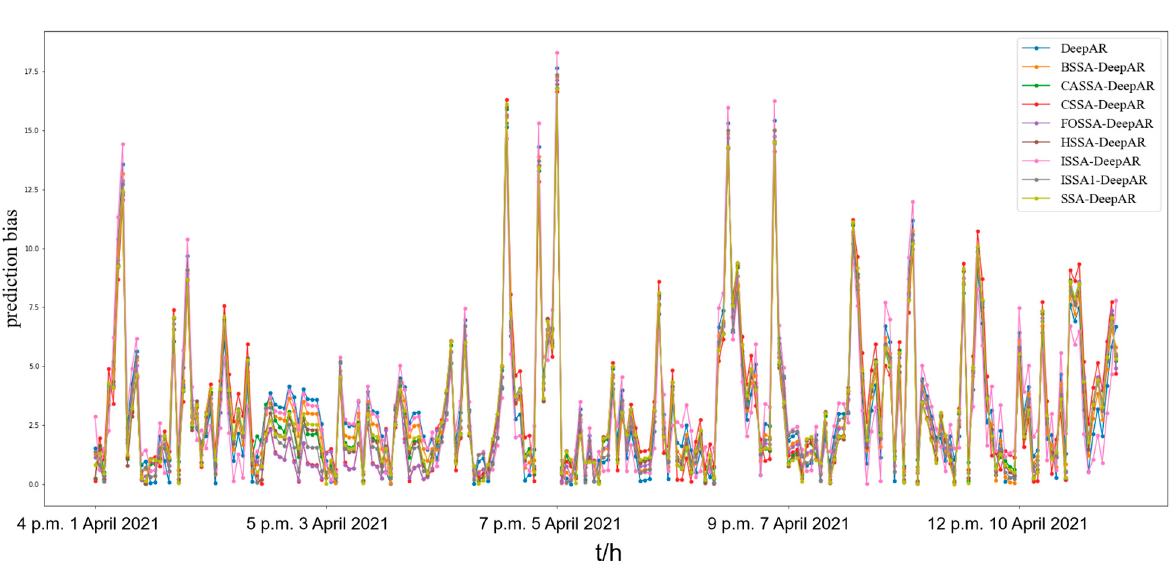
Figure 6. Prediction bias of PM2.5 concentration in Beijing. In the nine prediction models, the prediction bias of FOSSA– DeepAR is the smallest, which means FOSSA–DeepAR has best accuracy.